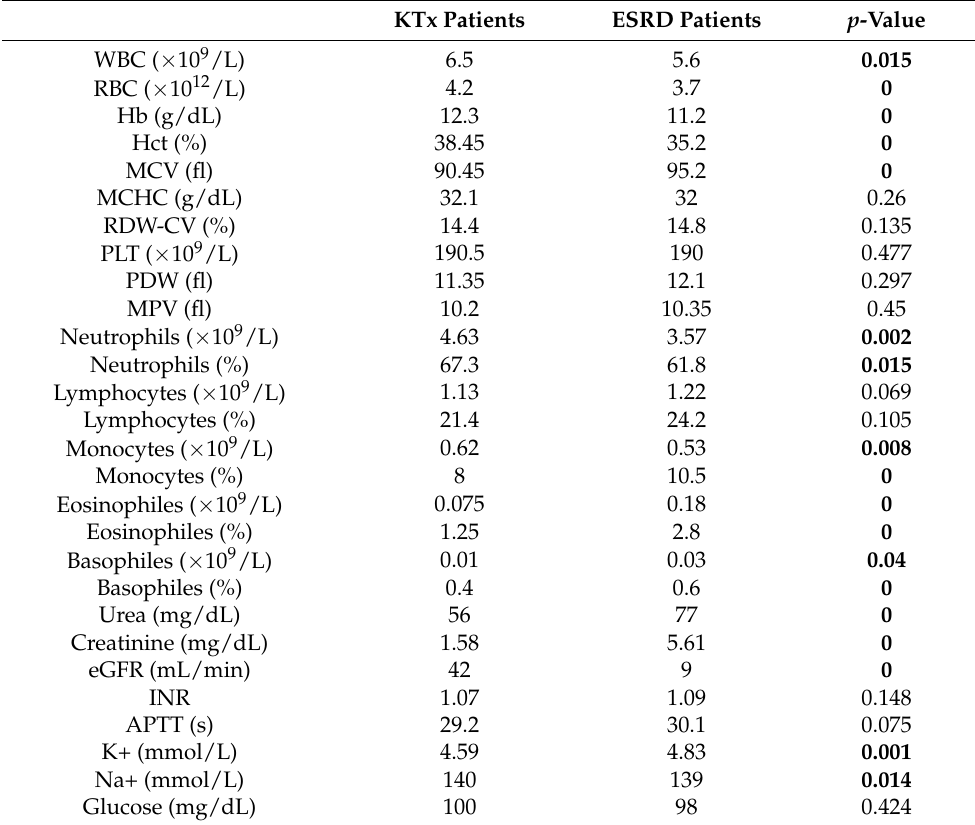
Table 4. Morphology and biochemical parameters—dialysis fistula aneurysm reconstruction in the kidney transplant recipients and the end-stage renal disease patients. KTx